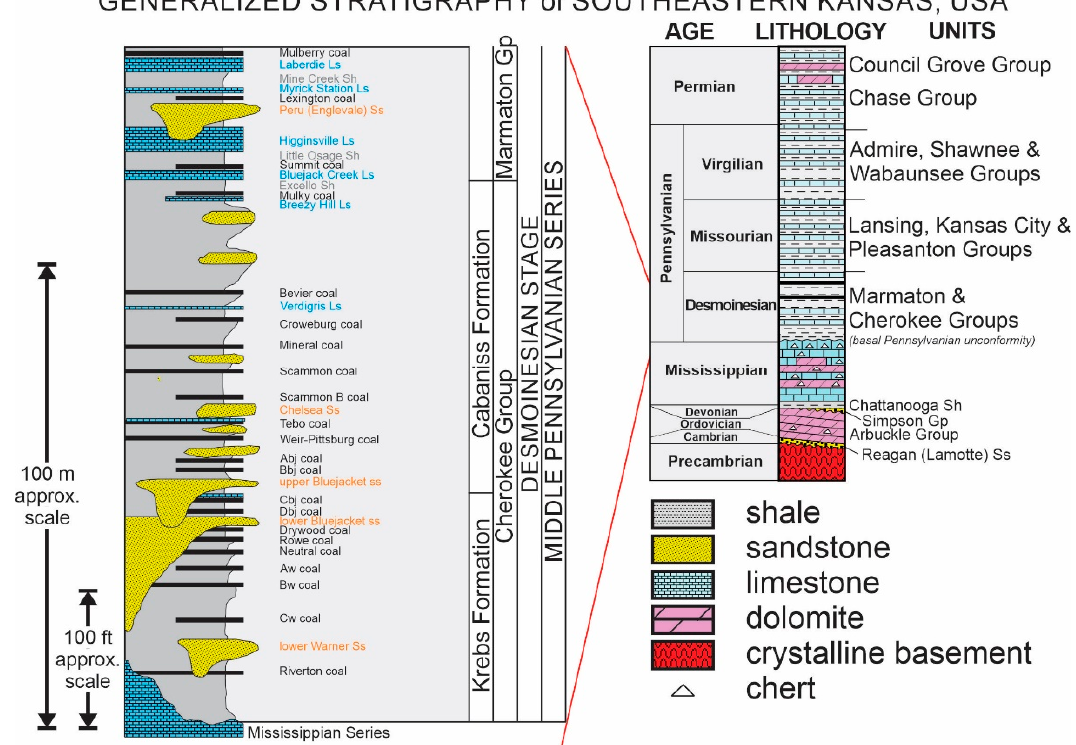
Figure 2. Generalized stratigraphy of the study area, from [46] . Note the Chattanooga Sh. is absent beneath the wells studied, and is present only in the extreme southeast part of Labette Co.